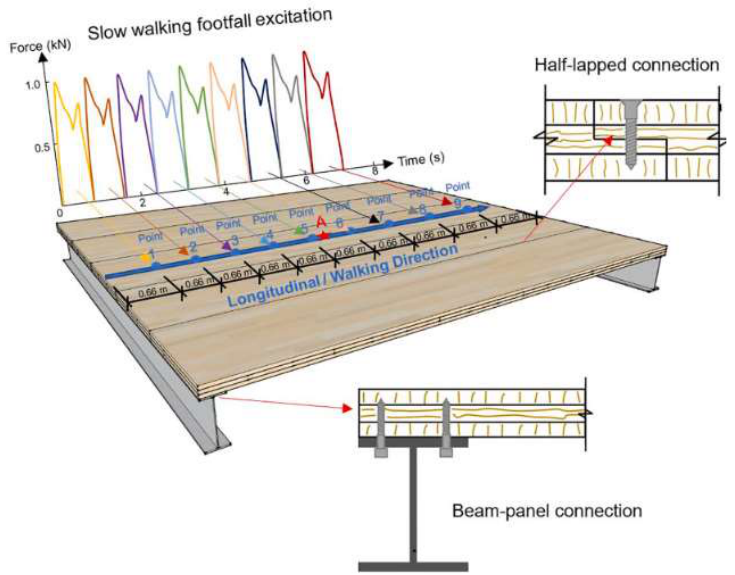
Figure 7. The scheme of human-loading used by Wang et al. [45]. Reproduced with permission. Table 9. The floor details and frequency results of STC floors studied by Wang et al. [45]. A mass of 0.5 ton was applied to represent the presence of the furniture.